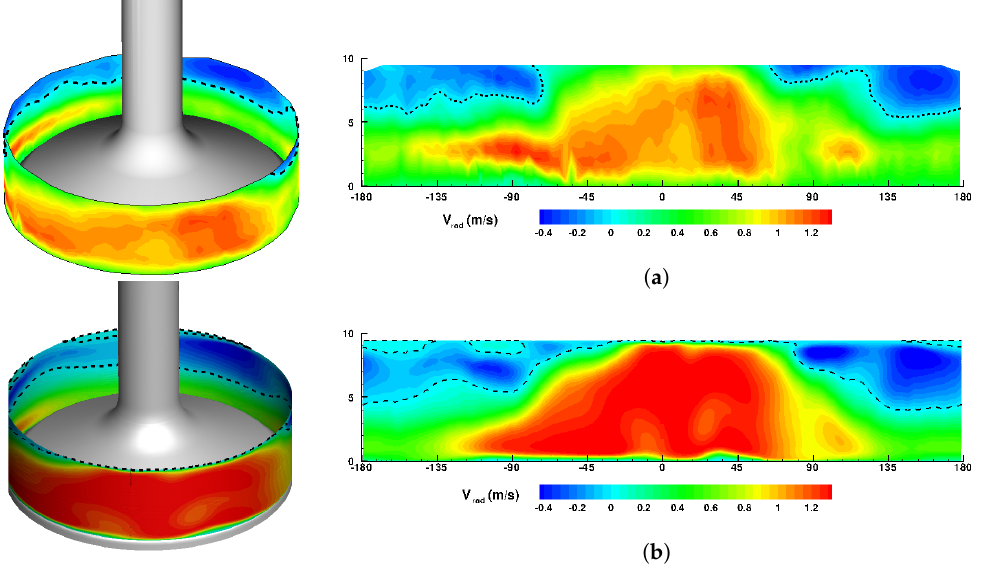
Figure 9. Comparison of velocity profile at valve curtain. ( a ) MRV [15]; ( b )